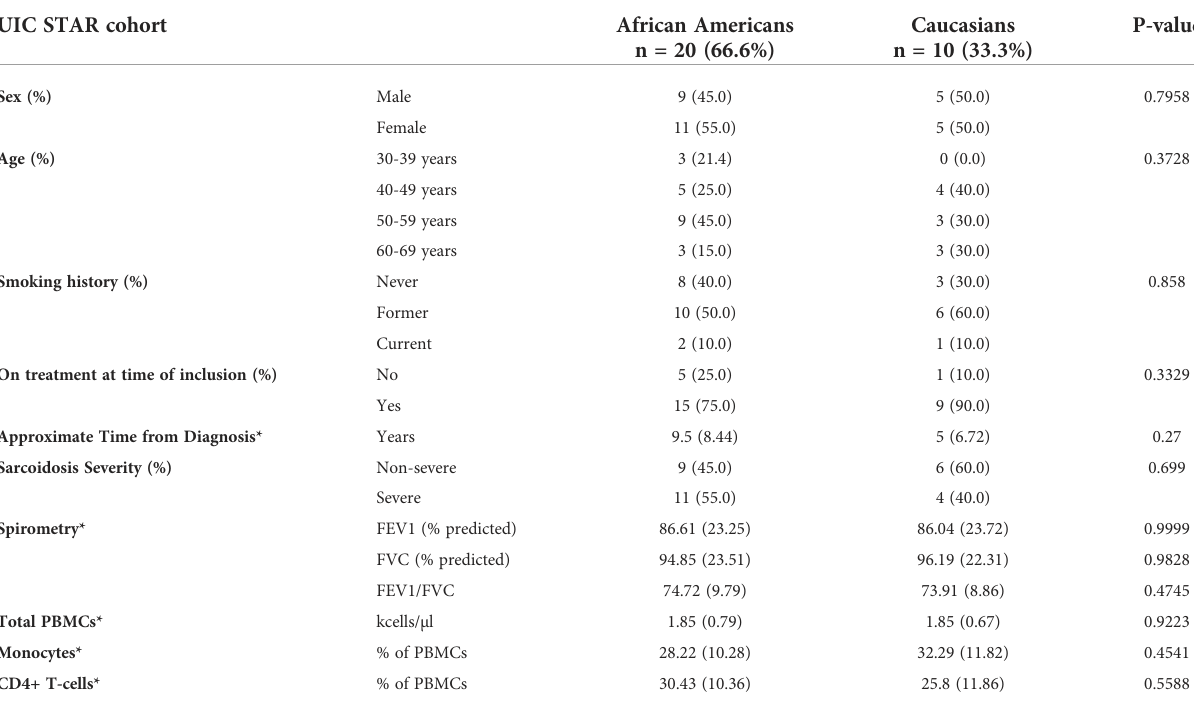
TABLE 3 Baseline characteristics of sarcoidosis cases from the “ University of Illinois at Chicago Bernie Mac Sarcoidosis Translational Advanced Research Center (UIC STAR) Cohort ” . UIC STAR